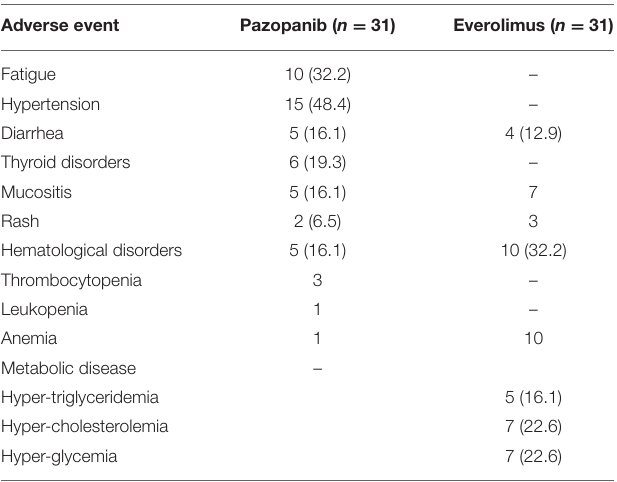
FIGURE 2 | Kaplan-Meier estimates of Overall Survival for sequence. TABLE 2 | Adverse events.